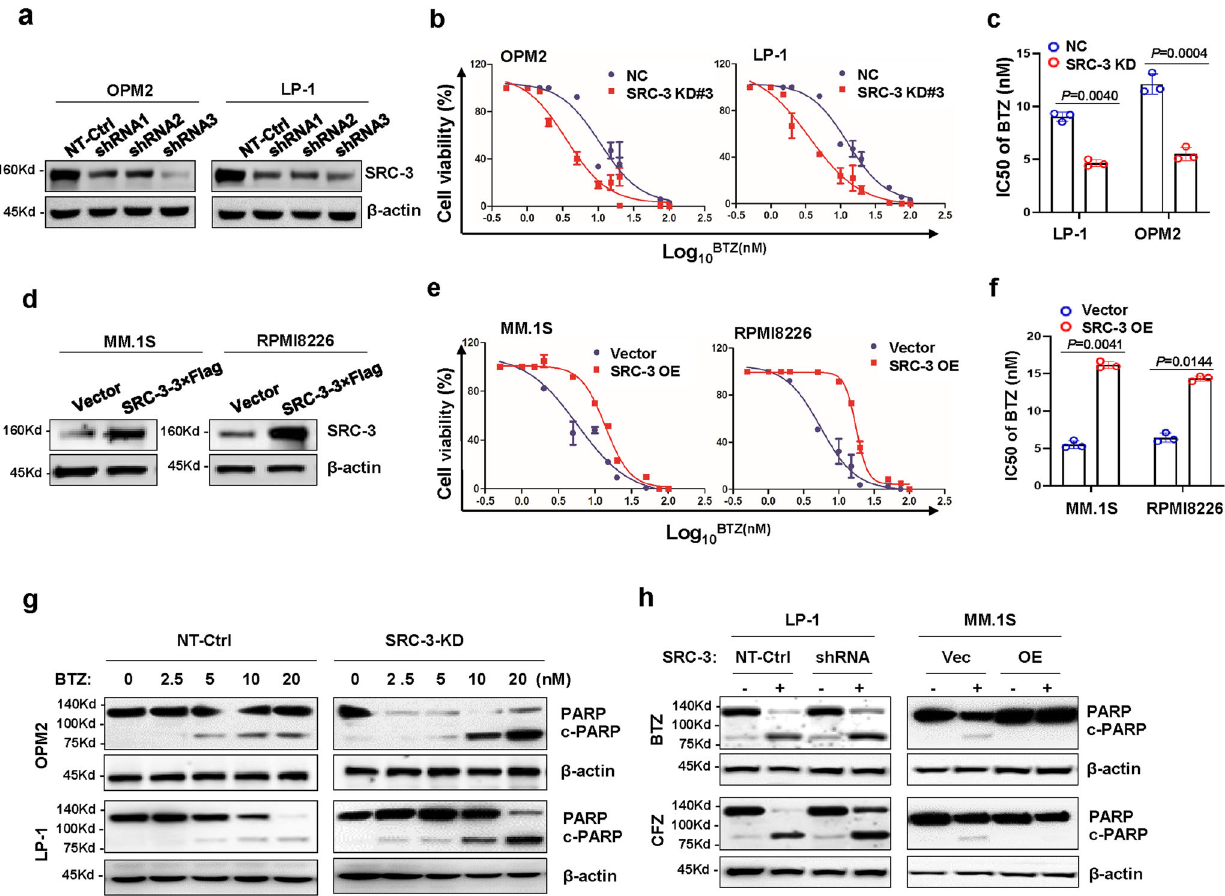
Fig. 3 Manipulation of SRC-3 expression alters sensitivity to BTZ treatment in vitro. a Representative Western blotting (n = 3 biologically independent experiments) shows the knockdown effects in OPM2 and LP-1 cells infected with lentivirus carrying three shRNAs targeting three different coding sequencing of NCOA3 gene (shRNA1, 2, 3) compared to the non-target control (NT Ctrl). b Alteration of IC 50 to BTZ treatment in the NT Ctrl (NC) and SRC-3 knockdown (KD) cells ( n = 3 biologically independent experiments; mean ± s.d.), and ( c ) comparison of the IC 50 values of NT Ctrl (NC) and SRC-3 knockdown (KD) cells ( n = 3 biologically independent experiments). Two-sided P -values were determined by Student ’ s t test; mean ± s.d. d Representative Western blot (n = 3 biologically independent experiments) shows the ectopic expression of SRC-3 in MM.1S and RPMI8226 cells infected with lentivirus carrying the SRC-3-3 × fl ag (SRC-3 OE) compared to the vector control (Vec). e Alteration of IC 50 to bortezomib (BTZ) treatment in the vector control (Vec) and SRC-3 overexpression (OE) cells ( n = 3 biologically independent experiments; mean ± s.d.). f Comparison of the IC 50 value in the vector control and SRC-3 overexpression cells ( n = 3 biologically independent experiments). Two-sided P -values were determined by Student ’ s t -test; mean ± s.d. ( g ) and ( h ) Cleavage of PARP as the apoptotic marker in myeloma cells with SRC-3 expression manipulated by shRNA or ectopic expressing vector, treated with increasing dosage of bortezomib (BTZ) and car fi zomib (CFZ, 5 nM) for 48 h ( n = 3 biologically independent experiments). Source data are provided as a Source Data fi